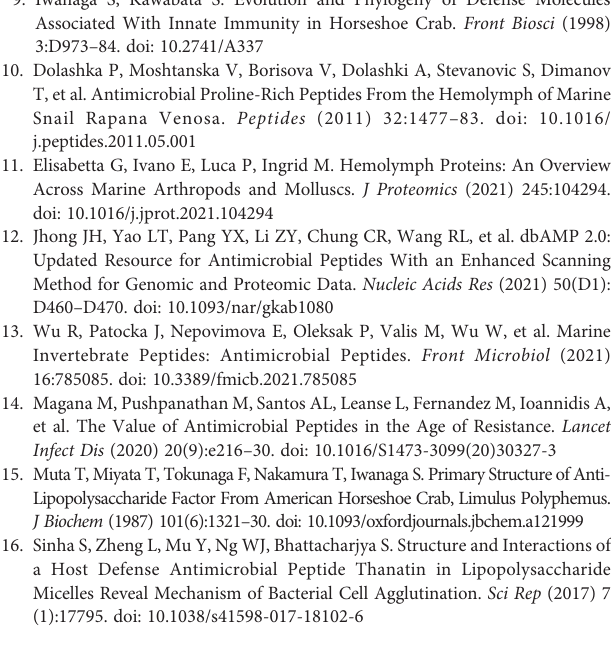
Supplementary Figure 1 | The model of A. hydrophila infection test in zebra fi sh. Zebra fi shinfectedwith A.hydrophila showedulceronskin,accumulationofascites,the intestinal bleeding, the bacterial overload in the digestive organs, and eventually